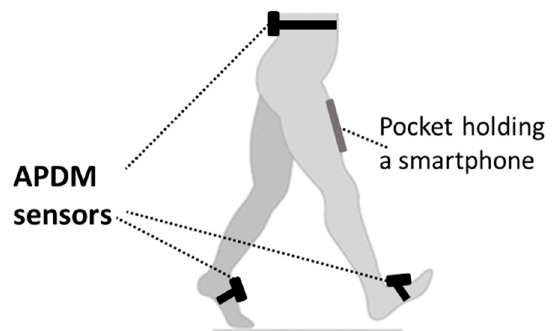
Figure 1. IMU setting. APDM mobility lab sensors were placed over participant’s clothing and were wrapped around the shoes to secure the sensor to the participant’s body. The plastic pocket used to hold the smartphone was fixed using belt-like Velcro straps.